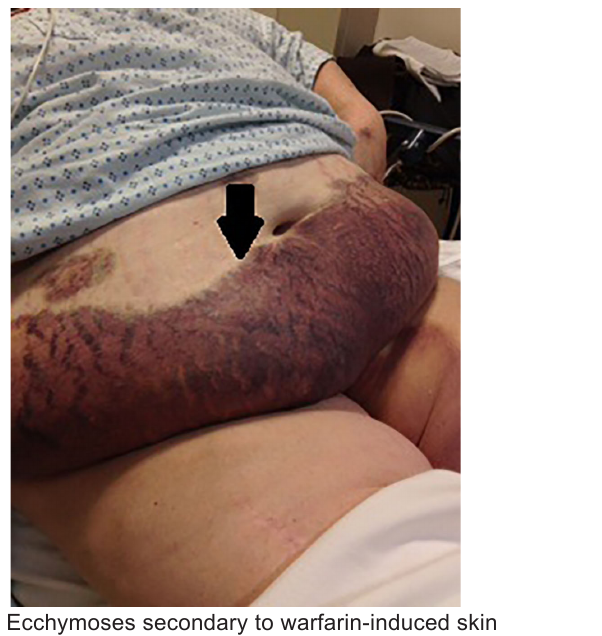
Image 1. Ecchymoses secondary to warfarin-induced skin necrosis